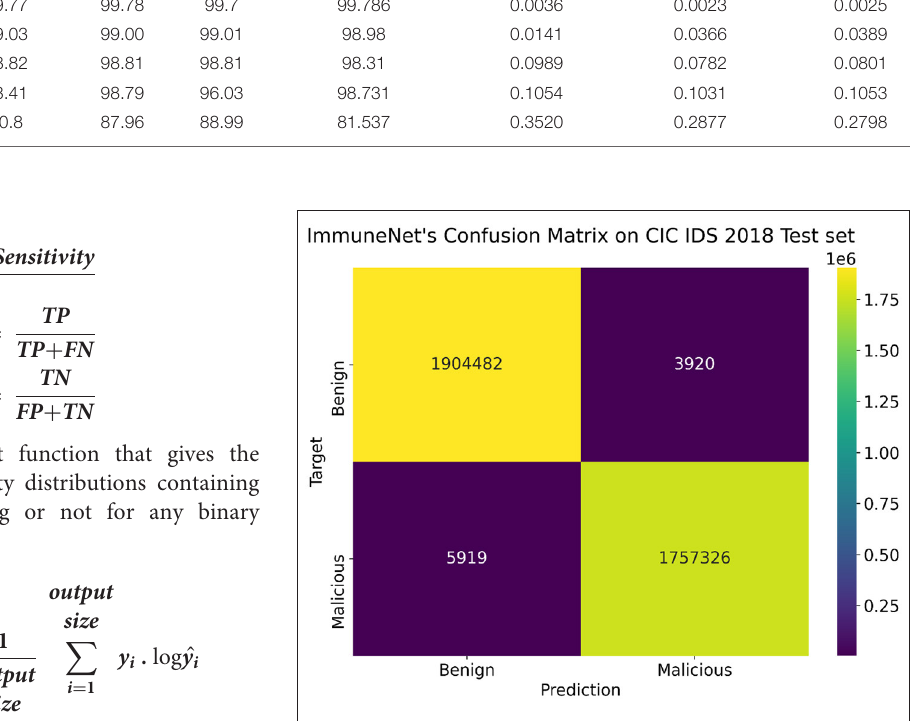
FIGURE 12 | Confusion matrix on the CIC IDS 2018 test set for ImmuneNet.